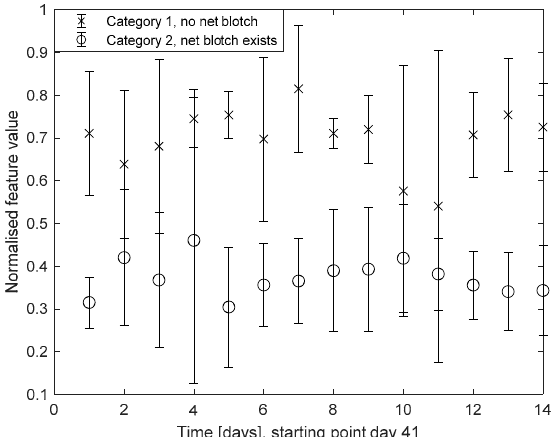
Figure 11. D sn values and their standard deviations with Category 1 and 2 data applying the best feature (Equation (3)) and starting time on day 41 from the beginning of the growing season (14-day data window).